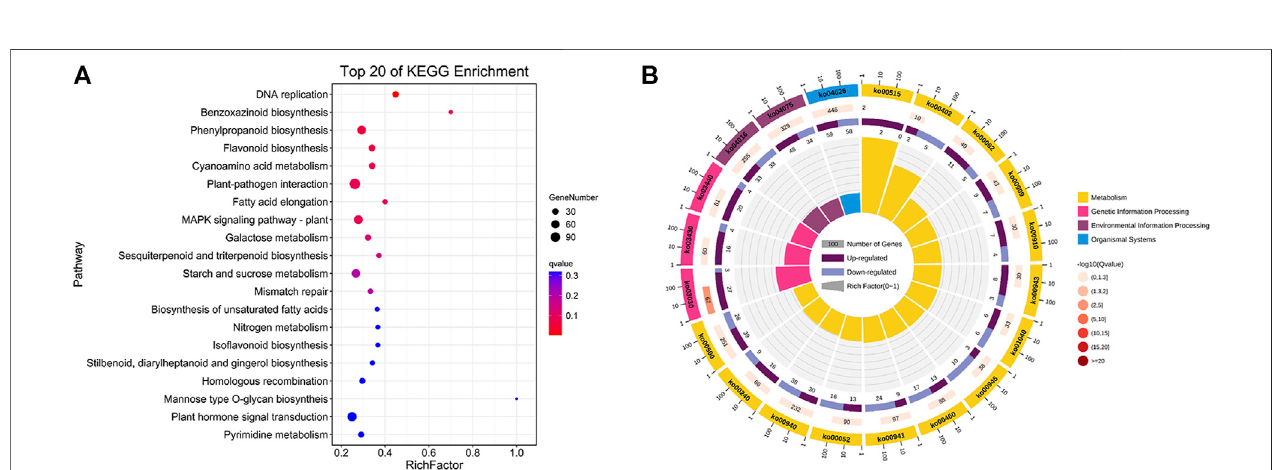
FIGURE 3 | KEGG enrichment analysis of DEGs between the SFs and PFs of mulberry. (A) The color of the balls indicates the p value of the KEGG enrichment analysis. Red indicates the highest p value and blue the lowest (least likely tooccur bychance), and the sizeof the ballrepresents the number of DEGs enrichmentin the pathway. (B) Top 20 enrichment pathways of DEGs are categorized in KEGG classi fi cation with differential colors.